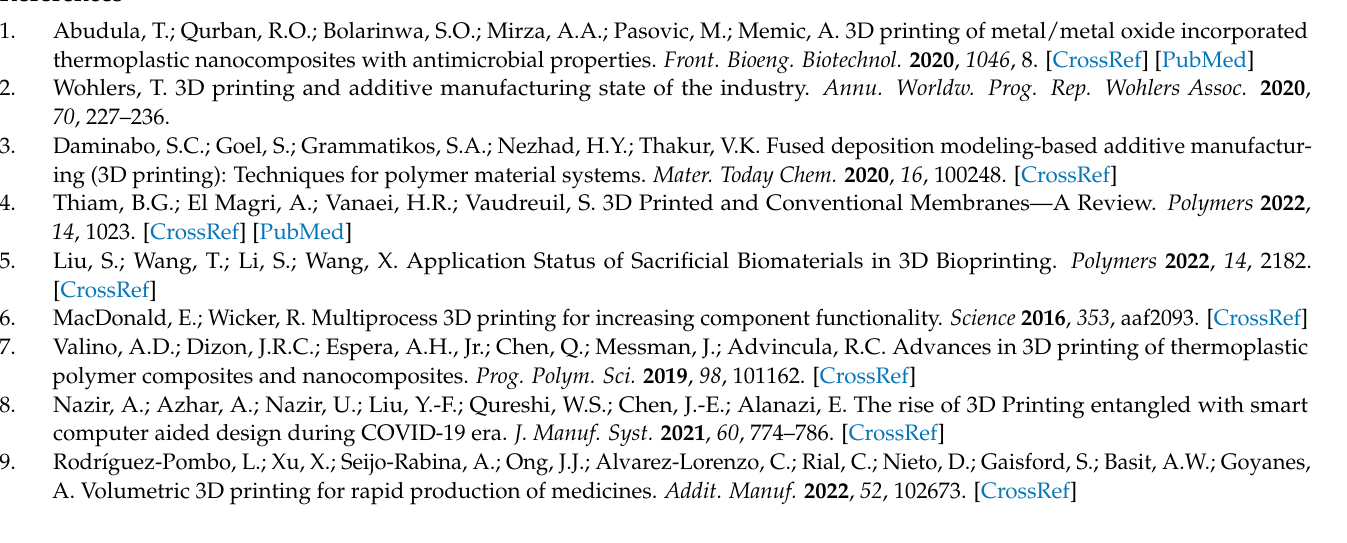
Figure S4. Inhibition zone of the composites with different mass fractions of lignin coated by Ag/ZnO against Escherichia coli